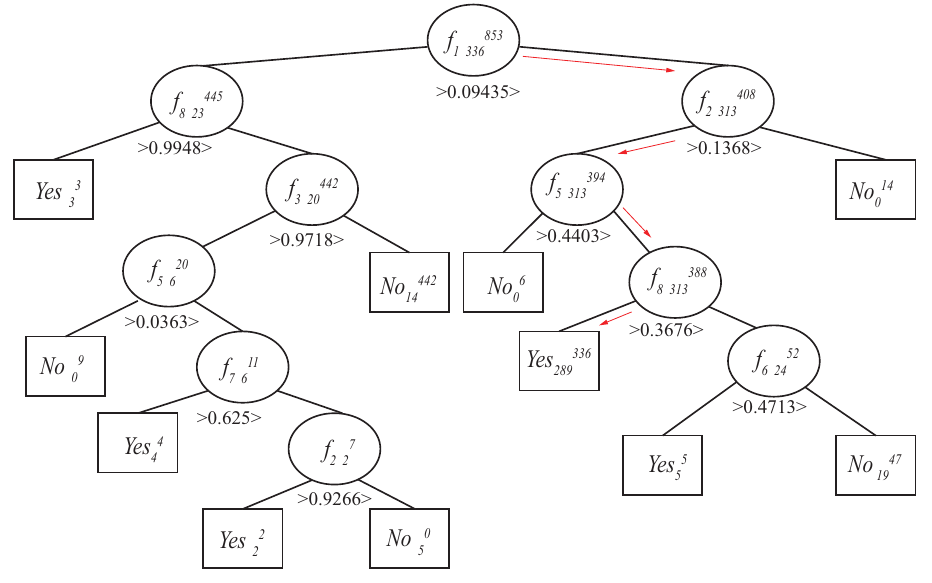
Figure 10. Final established decision